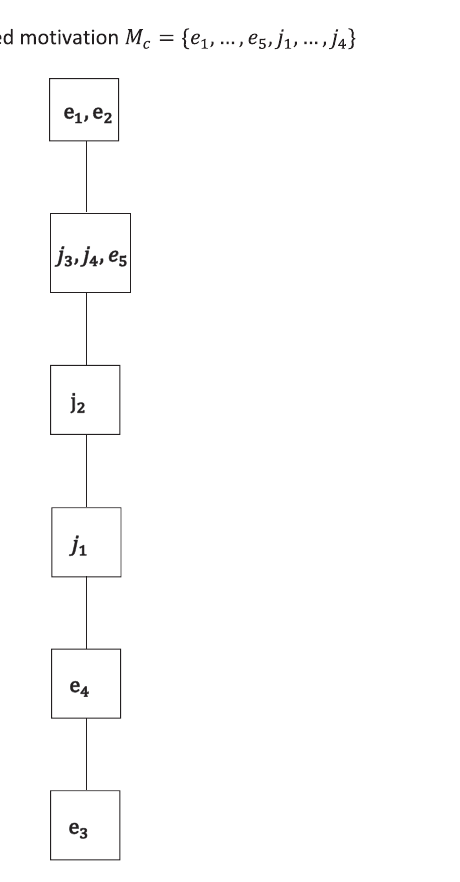
FIGURE4 The IITA quasi-order solutions for autonomous motivation (A) and controlled motivation (B) of the empirical data set. By Birkhoff’s theorem, the corresponding quasi-ordinal motivation spaces are M a = {∅ , { d 1 ,..., d 3 } , { i 2 , d 1 ,..., d 4 } , { i 1 ,..., i 5 , d 1 ,..., d 4 } , M a } , and M c = {∅ , { e 3 } , { e 3 , e 4 } , { e 3 , e 4 , j 1 } , { e 3 , e 4 , j 1 , j 2 } , { e 3 ,..., e 5 , j 1 ,..., j 4 } , M c } , respectively. We see cumulative gradations of autonomous motivation and controlled motivation. This corroborates the higher-order interpretation of the basic motivations in these two